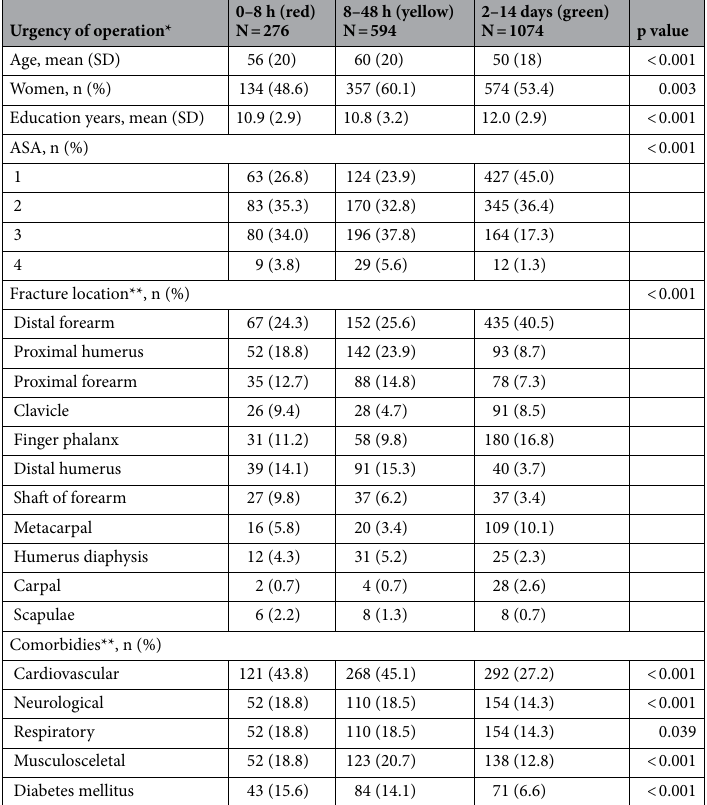
Table 1. C haracteristics of the study population. *According to the traffic light coding. ** Number and percentage calculated for each group. Clarification: the delay from the treatment decision to surgery has only been available since 2013. Before 2013, 788 (181 red, 260 yellow, and 347 green) patients were